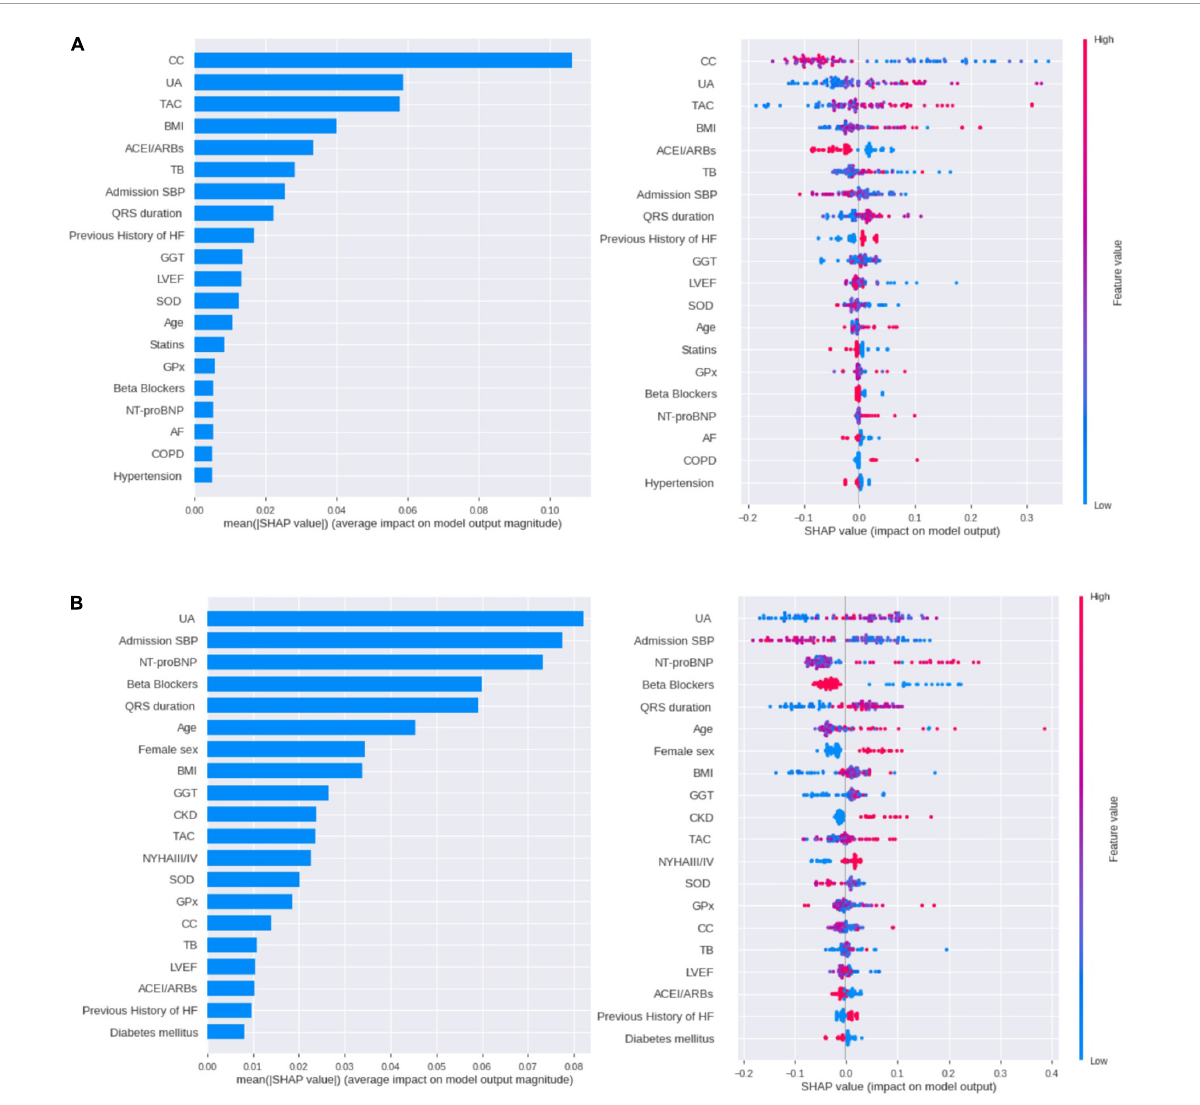
FIGURE3 SHAP plots for the ML models in predicting post-discharge mortality using (A) RF and (B) XGBoost. In each variable importance row, all patients’ attribution to mortality risk was plotted using different color dots. The red dots represent the highest risk of death.